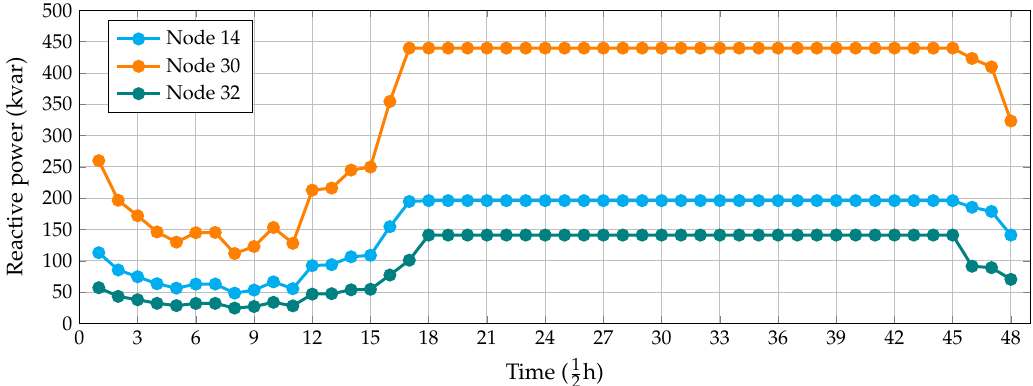
Figure 3. Daily reactive power injection in the selected nodes where the STATCOMs were installed in the IEEE 33-bus